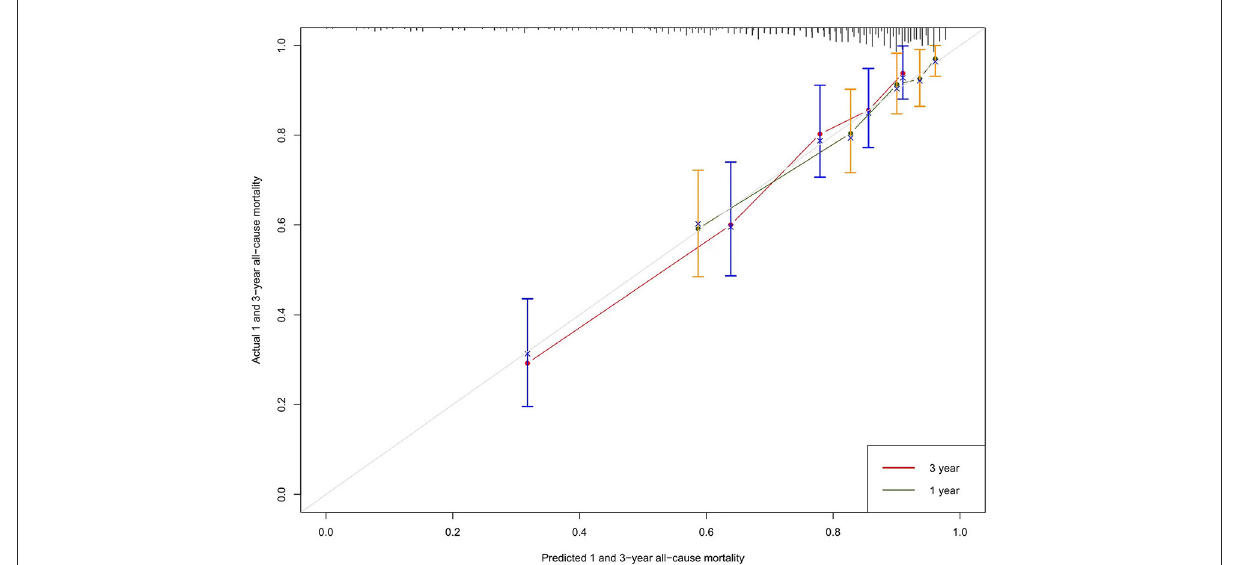
FIGURE2 Calibration curve: The abscissa is the predicted event rate, and the ordinate is the observed actual event rate, both ranging from 0 to 1, which can be understood as the event rate (percentage). The gray line of the diagonal is the reference line, i.e. the case where the predicted value = the actual value. The gray green and red curves represent the 1 - and 3-year model fit lines, respectively, and the two sides with color parts are 95% confidence interval.